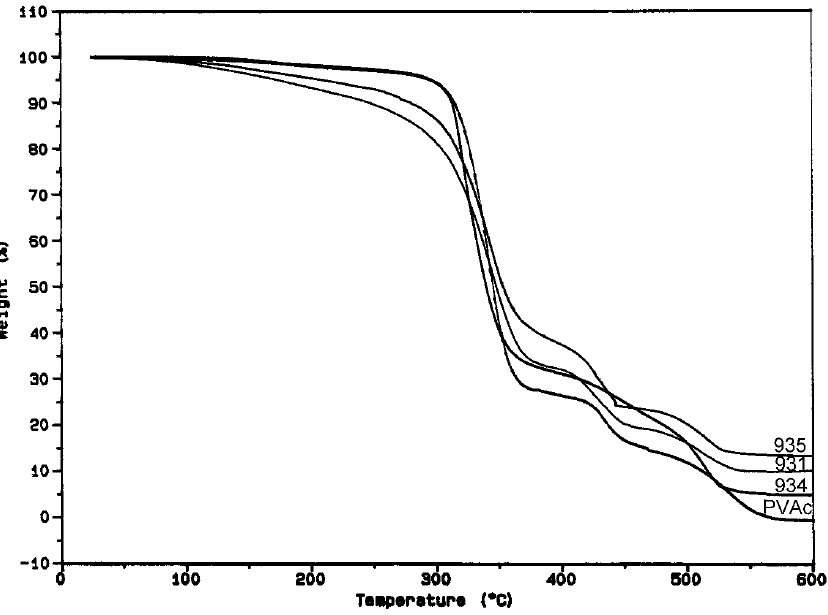
Fig. 4 TGA diagram of products with PVAc (s.931: PVAc+TIP; s.934: PVAc+TIP+OTES; s.935: